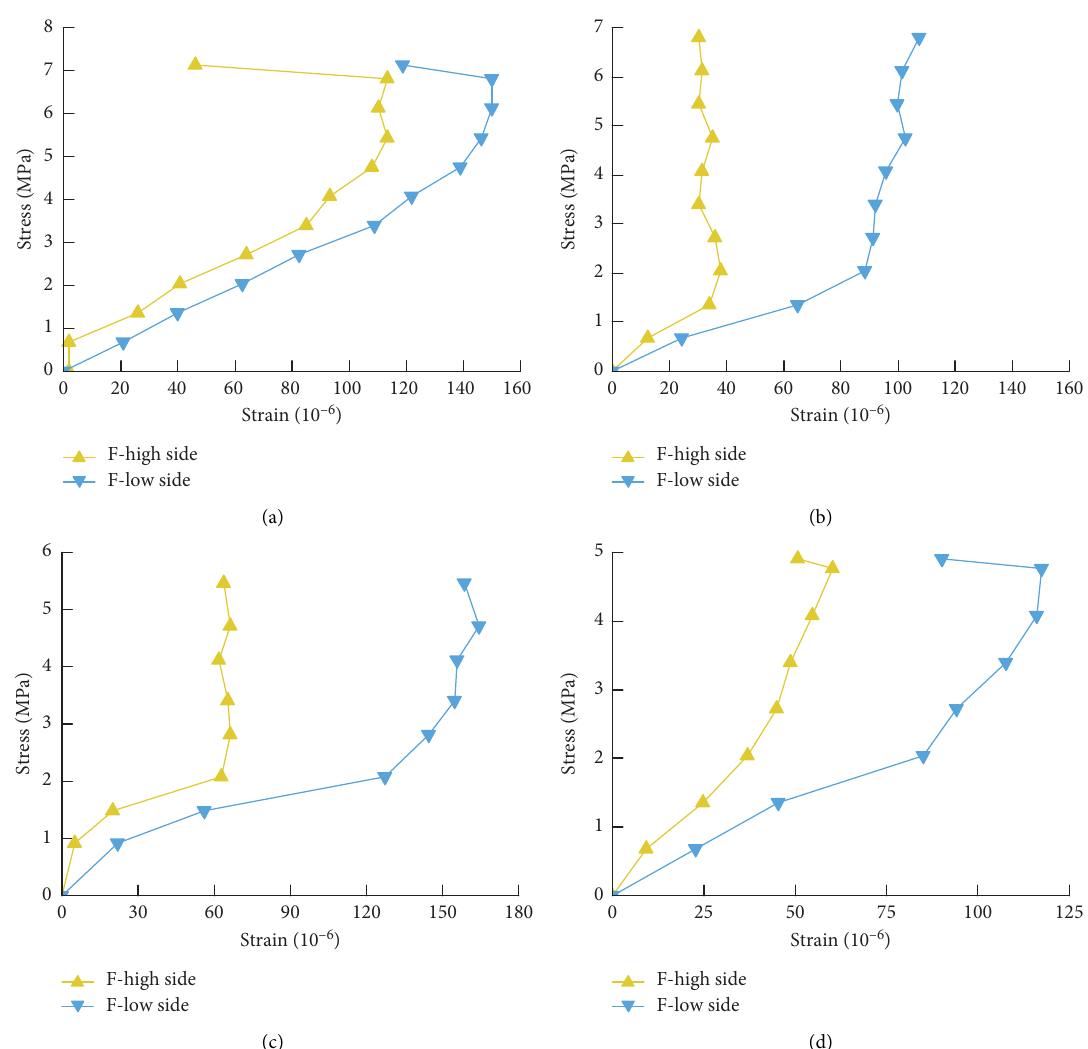
Figure 15: Stress-strain curve of roadway floor. (a) 18 ° . (b) 21 ° . (c) 24 ° . (d) 27 °